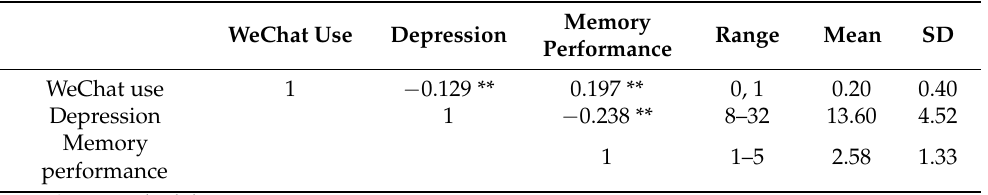
Table 3. Correlations among the variables of interest.